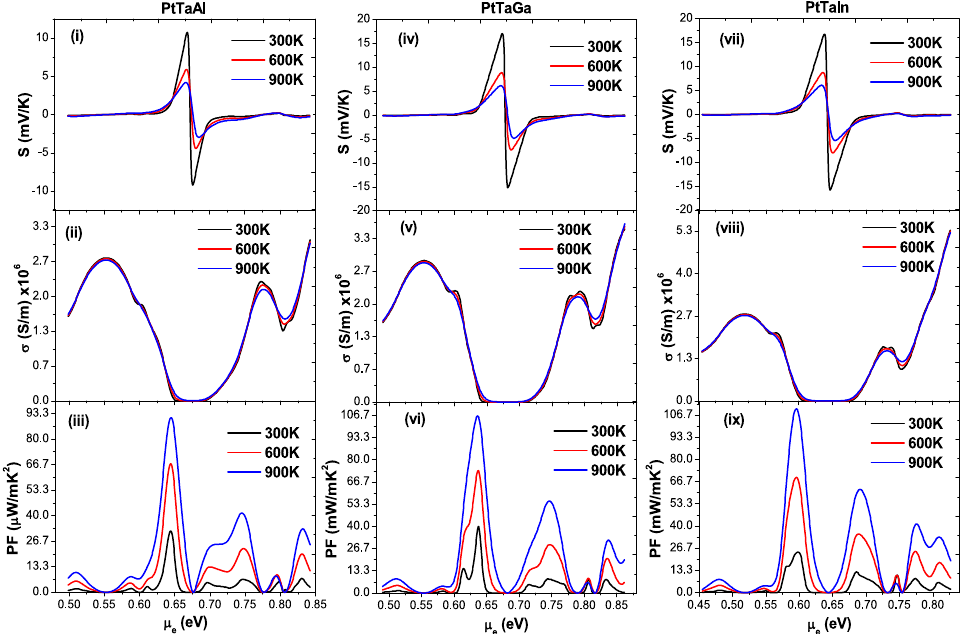
Figure 6. Transport coefficients of PtTaX(X = Al, Ga, In) alloys as a function of chemical potential: ( i , iv , vii ) Seebeck coefficient, ( iii , v , viii ) Electrical conductivity and ( iii , vi , ix ) Powerfactor.